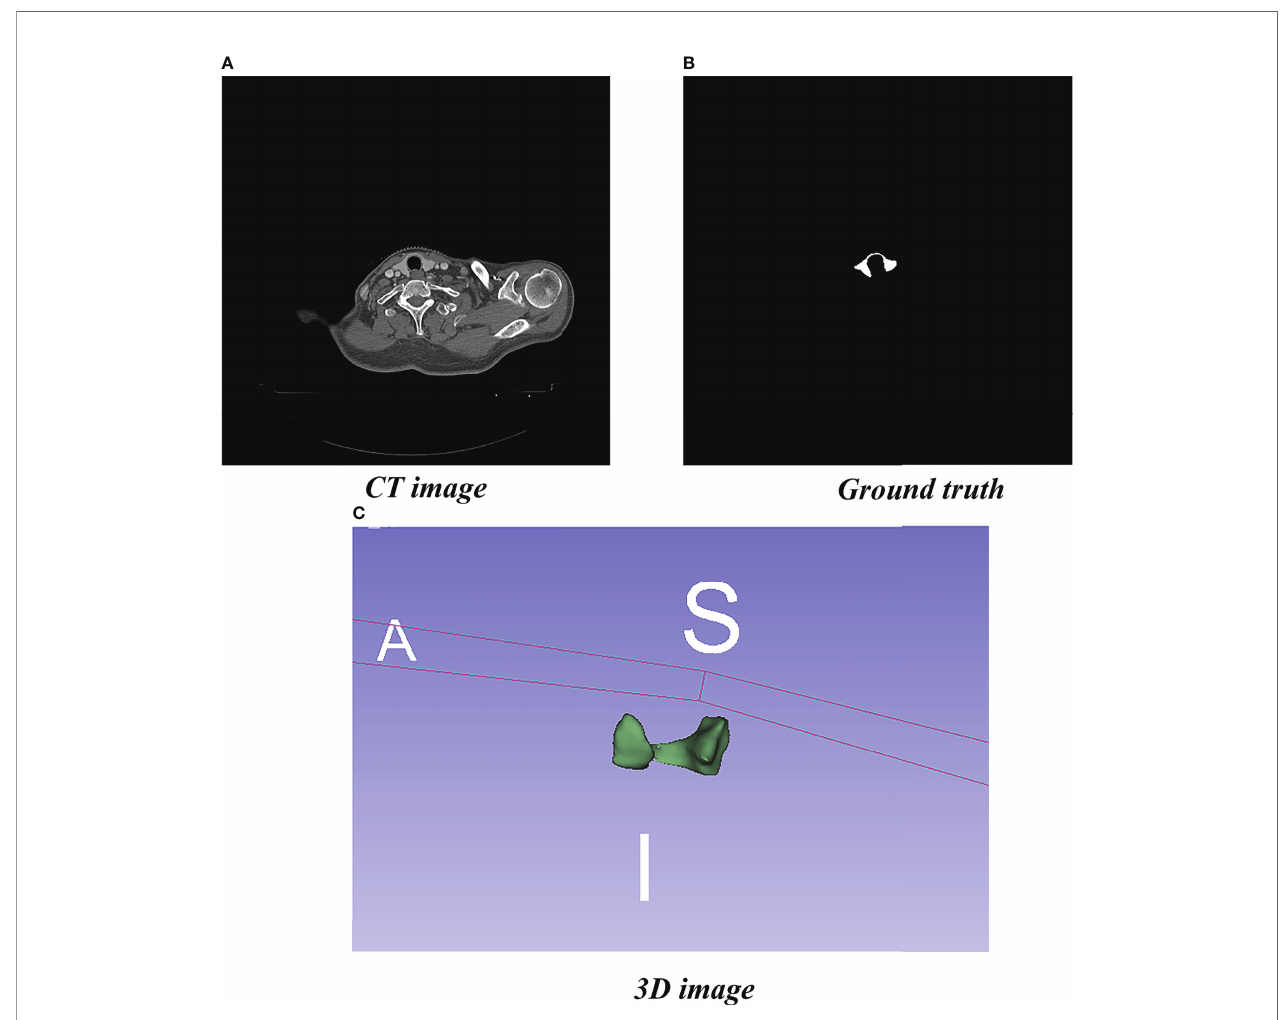
FIGURE 1 | Localized CT image, Ground truth, and 3D image. (A) Standard image of the imported model (CT image). (B) Corresponding label image (Ground truth). (C) Thyroid gland drawn in